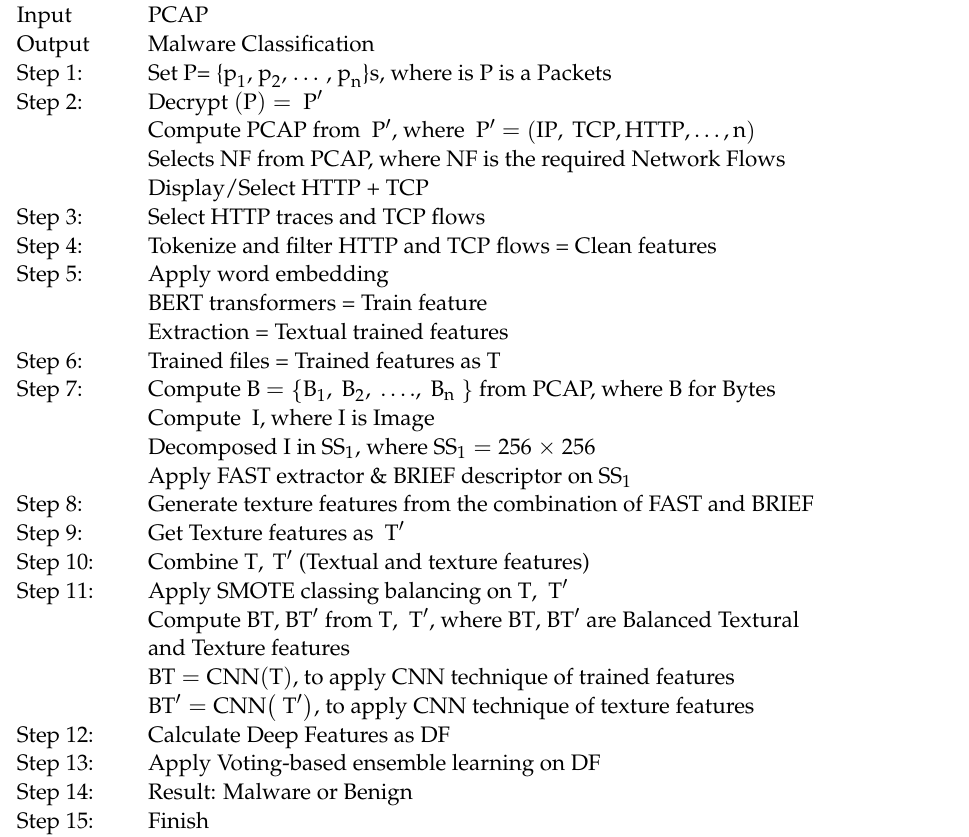
Algorithm 1: Malware Classification Using Transfer Learning and Texture